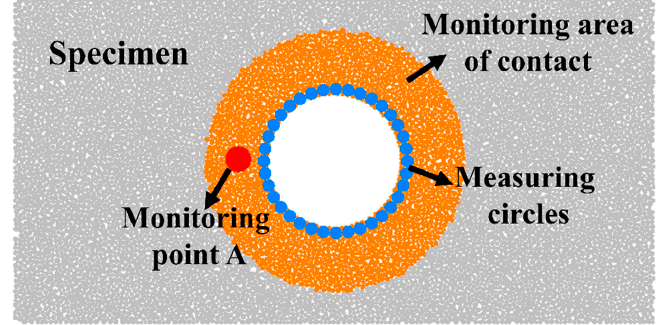
Figure 10. Evolution of cracks around the hole.